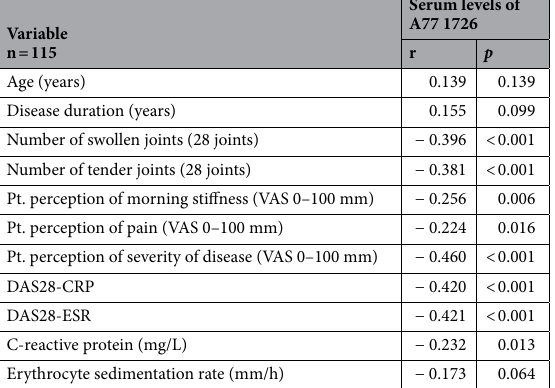
Serum levels of A77